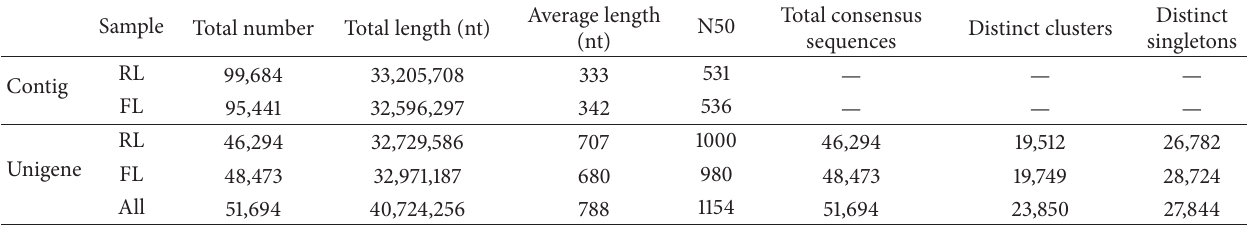
Table 1: Overview of the sequencing and assembly.